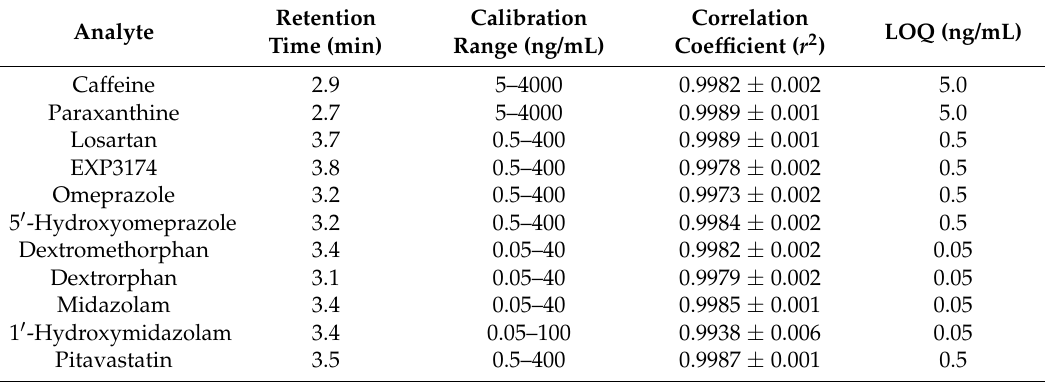
Table 1. Calibration range, linearity, and limit of quantitation (LOQ) of analytes.